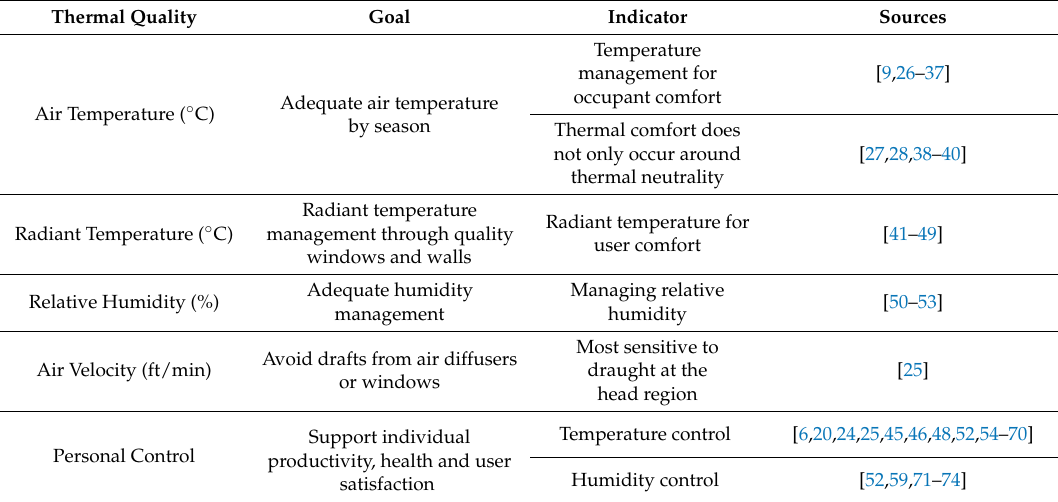
Table 1. Indices of thermal quality assessment and